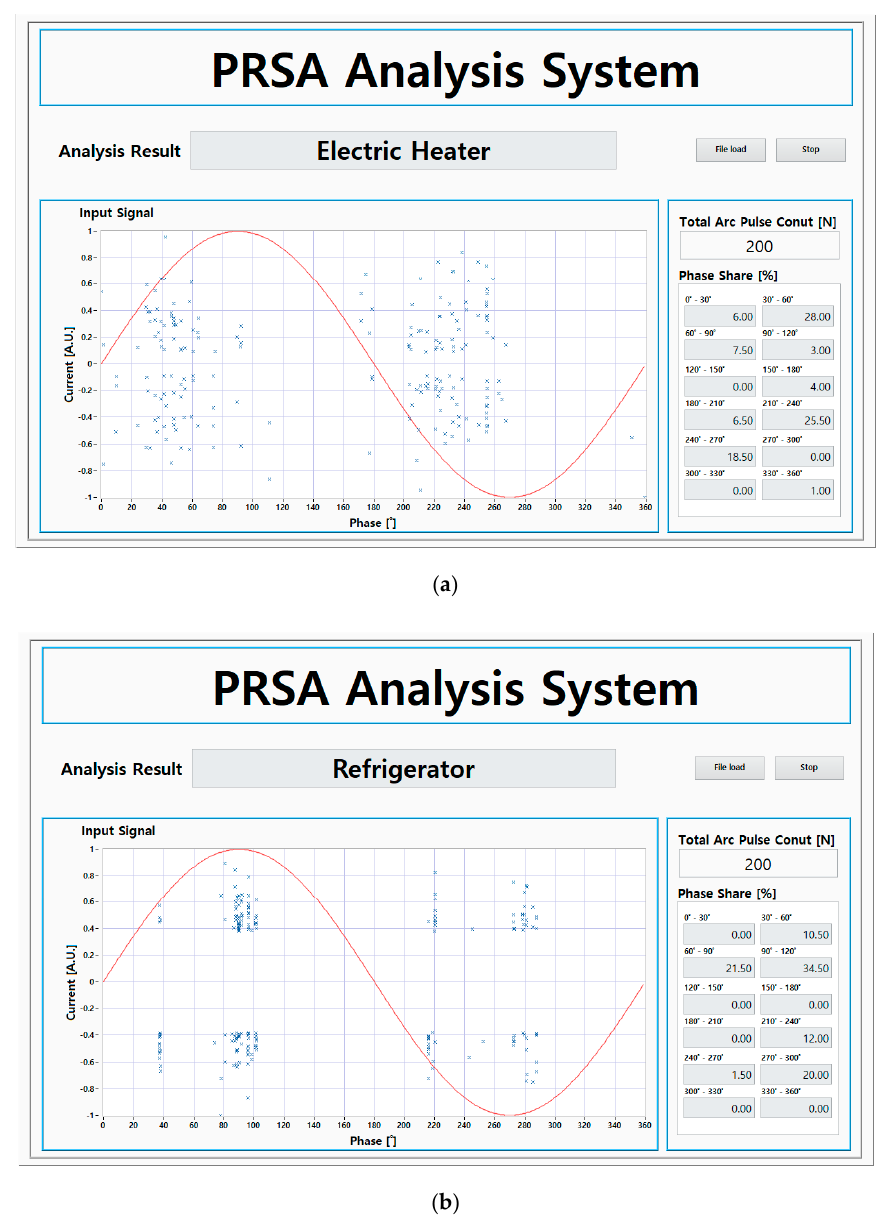
Figure 10. Application of the PRSA algorithm. ( a ) Electric heater; ( b ) refrigerator.